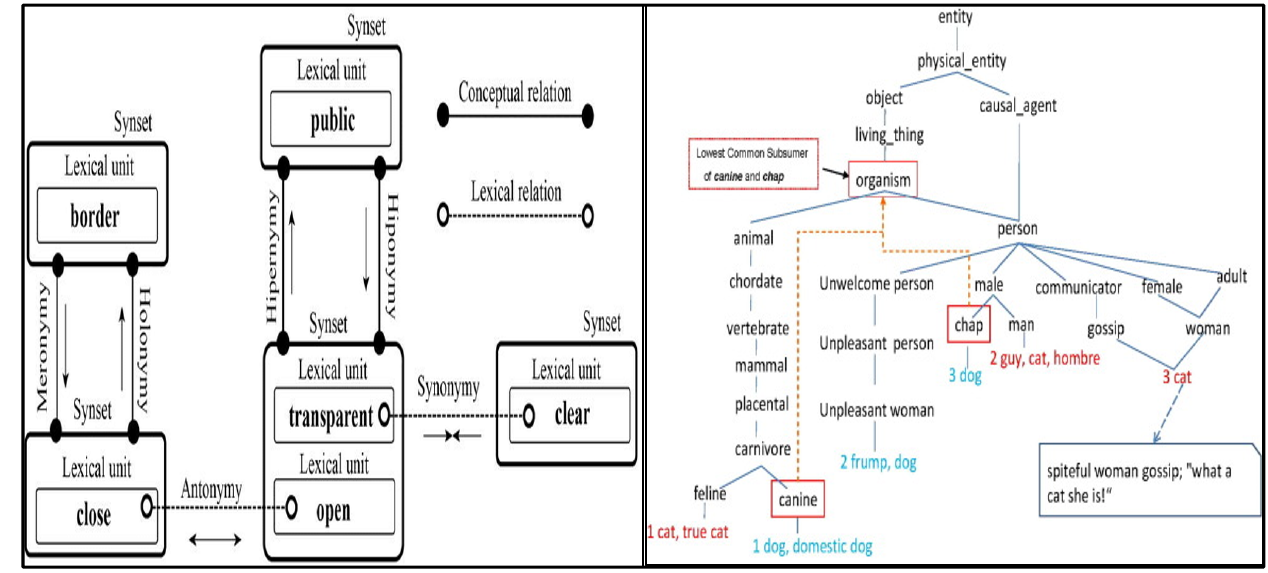
Figure 5. Terms synsets